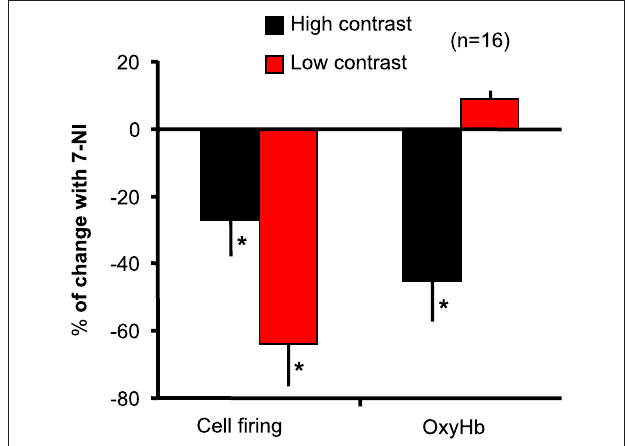
FIGURE 6 | Effect of stimulus intensity on the coupling between blood fl ow and neural response. The values of blood fl ow, as measured by OxyHb levels, are directly compared to neural responses for control and 7-NI conditions, under each of two stimulus conditions – high (100%) contrast and low (10%) contrast. When nNOS is blocked there is no signifi cant effect on blood fl ow during the presentation of low contrast stimuli, even when neuronal activity levels were signifi cantly reduced. *Represents signifi cant differences ( t -test; p <